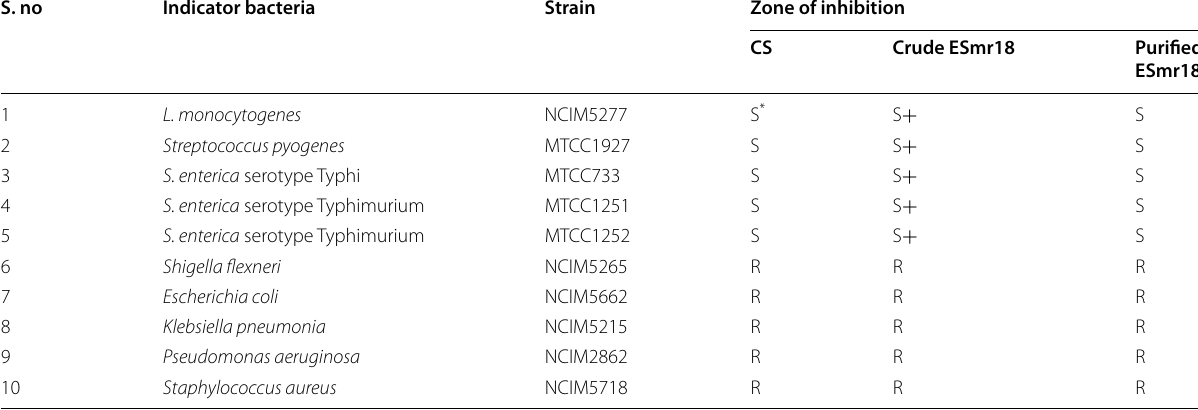
Table 1 Antimicrobial activity of the CS, crude and purified ESmr18 of E. faecium against various pathogenic indicator bacteria